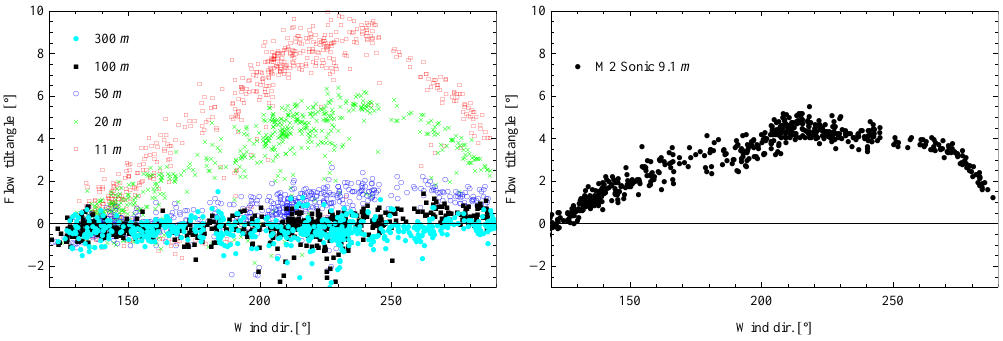
the flow angle as a result of the inhomogeneity of the